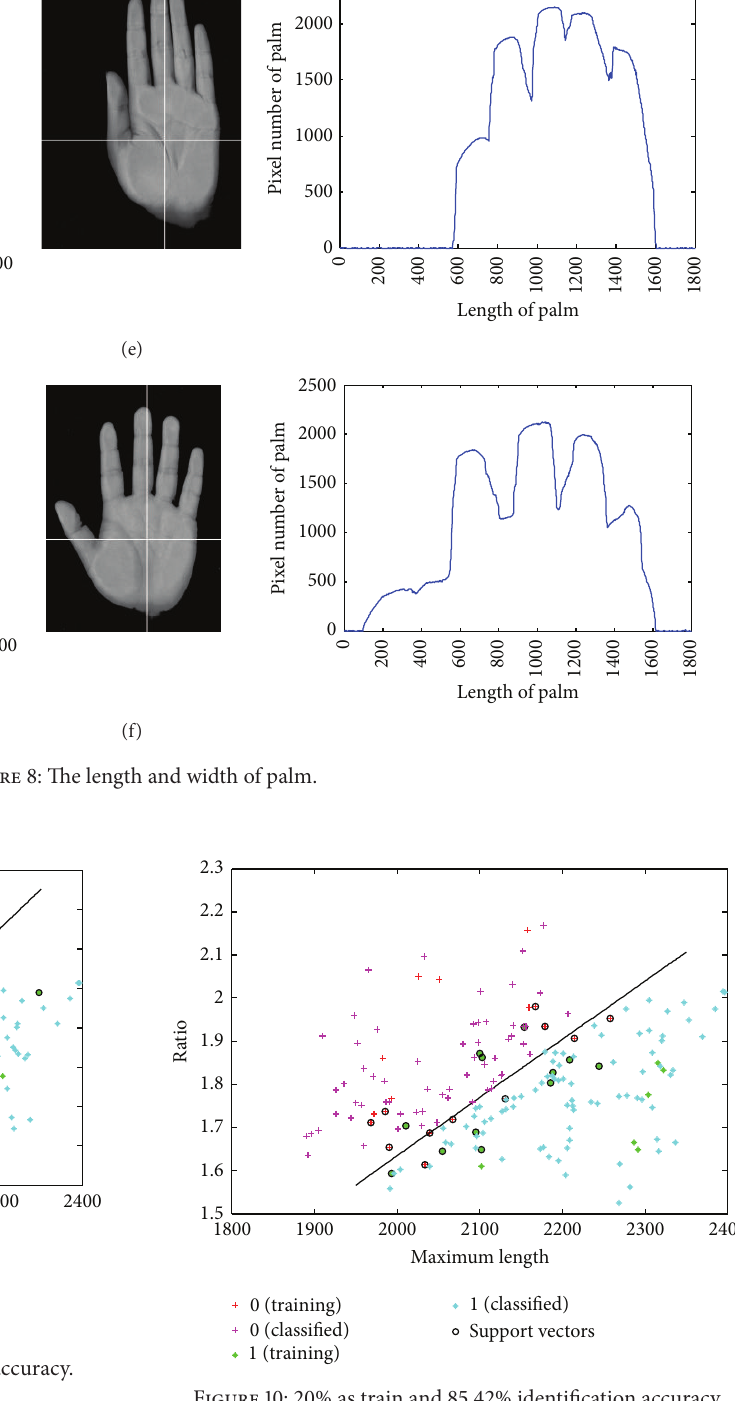
Figure 10: 20% as train and 85.42% identification